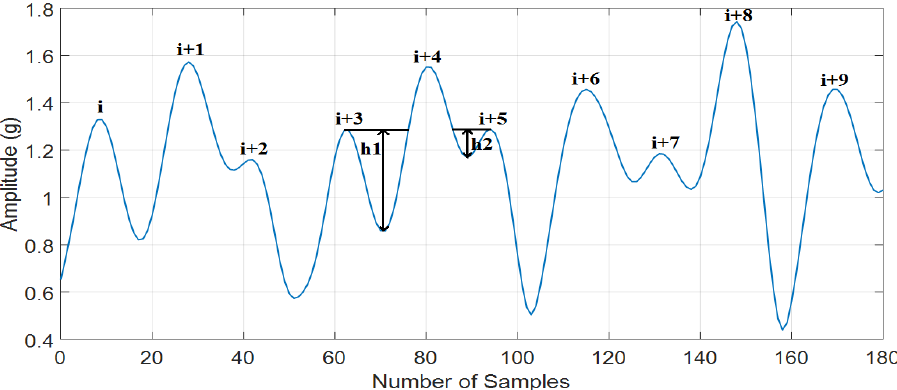
Figure 7. The minimal peak prominence analysis.